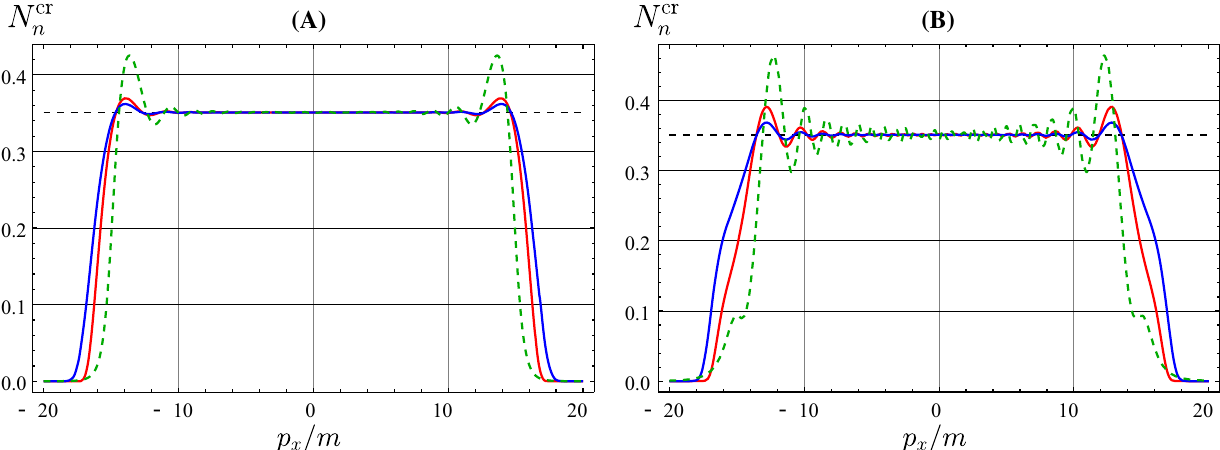
T -constant field while the horizontal ones denotes the uniform distri- bution e − πλ . In both graphs, m τ = 1, mk − 1 = 1, mT = 10 and E = 3 E